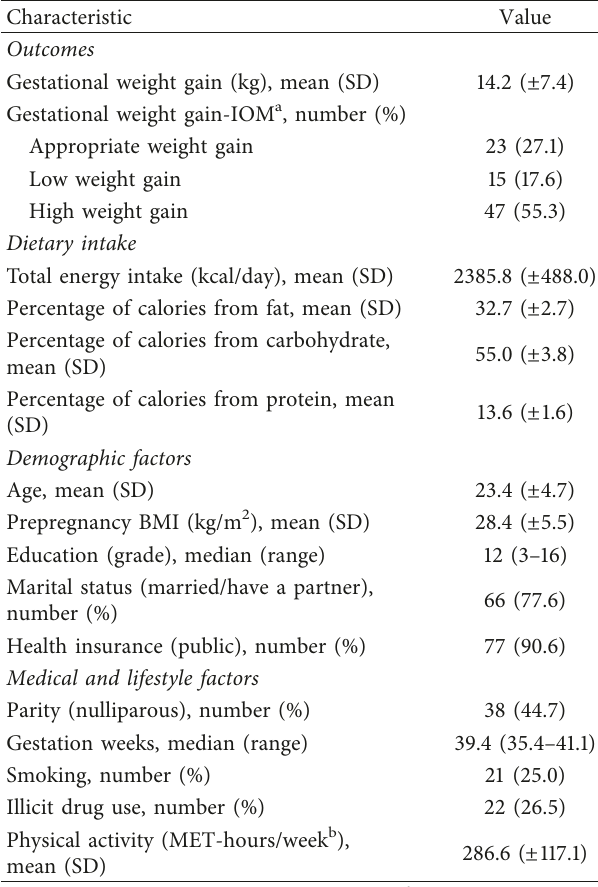
Table 1: Characteristics of the sample ( N �